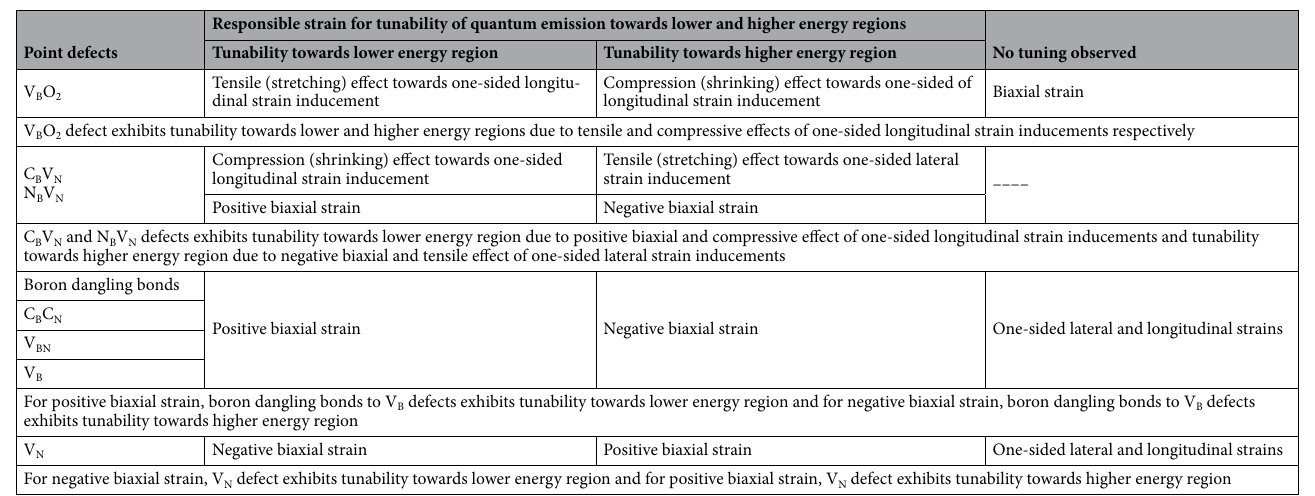
Table 6. Summary table of tunability of various point defects for different external strain